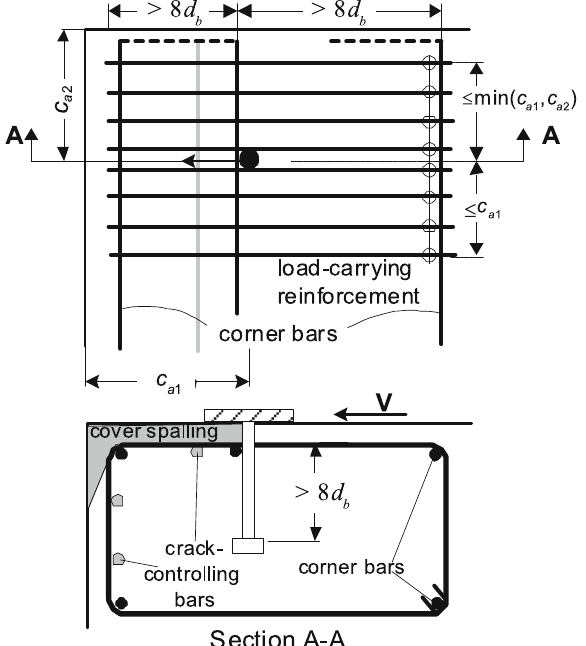
Fig. 2 Proposed anchor shear reinforcement by Petersen and Zhao (2013).